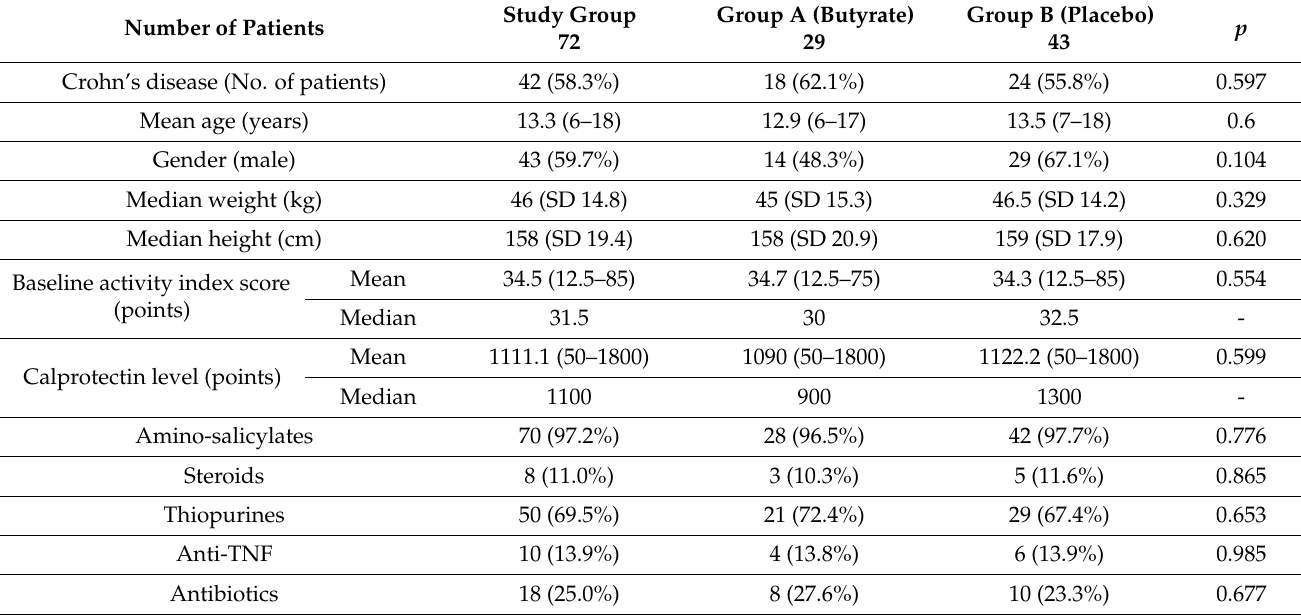
Figure 1. Flowchart of the study according to the CONSORT statement. Table 1. Baseline characteristics of the study group.